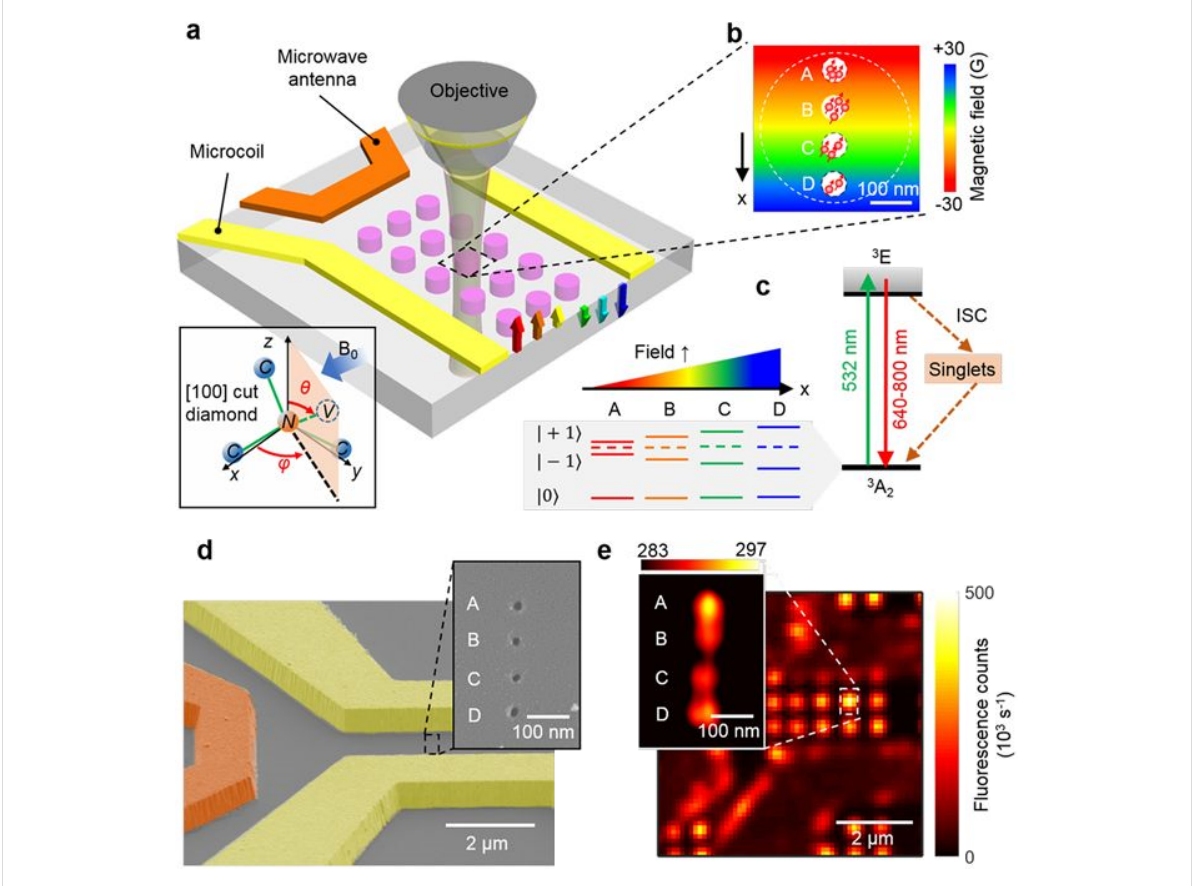
Figure 2: Experimental set-up and characterization of NV centers and the gradient microcoil of [43]. Image reproduced with permission from [43], an article licensed under a Creative Commons Attribution 4.0 International License, https://creativecommons.org/licenses/by/4.0/. (A) Experimental appa- ratus. A matrix of implantation regions (pink circles) of negative charge NV centers on the diamond is integrated into a scanning confocal microscope. A green laser (532 nm) is used to initialize and read out NV center spin states in a given region and microwaves emitted by an antenna (orange bar) manipulate them. A uniform magnetic bias field of B 0 = 128 G is applied along one range of NV orientations, causing a Zeeman line splitting among |±1 ⟩ NV center spin states; without a magnetic field they would show a 2.87 GHz frequency shift from the |0 ⟩ state. An added gradient magnetic field (rainbow-colored arrows) of ≈ 0.1 G·nm − 1 is applied by injecting current along a pair of gold wires (gradient microcoil), inducing the Zeeman shift depending on the position. (B) Each region (pink circle in a) holds a 1 × 4 array of NV sites with 60 nm diameter and 100 nm spacing, which undergo interaction that depends on the gradient in the magnetic field. Each site typically holds multiple ( ≈ 3 ± 1) NVs of the selected orientation. (C) NV energy-level diagram. A nonradiative intersystem crossing channel exists between the ground (3A2) and excited (3E) states, and the magnetic field gradient causes the NV center spin states |±1 ⟩ Zeeman splitting to be dependent on their position. Each site has a specific resonance that the micro- wave generator can be tuned to, allowing for selective detection of each site. (D) Gradient microcoil SEM image on the diamond substrate. The micro- coil, represented by yellow pseudo-color, is 1 µm thick and 2 µm wide. (Inset) E-beam resist apertures on PMMA, SEM image of ion implantation mask to create a 1 × 4 array of NV sites. (E) Microcoil and NV center matrix image by scanning confocal microscopy. (Inset) STED image of 1 × 4 array of NV sites with 50 nm resolution. Photon count rate (kilo-counts-per-second) is shown by color